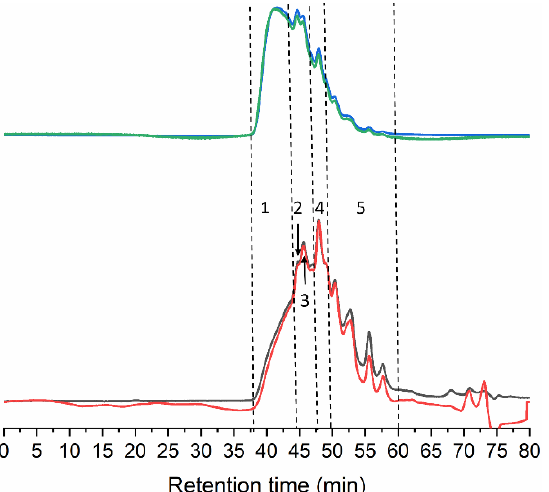
Figure 2. GPC eluograms of gelatin extracted from the skin of tuna. Blue line: right angle light scattering; green line: low angle light scattering; red line: refractive index; black line: ultraviolet (280 nm).